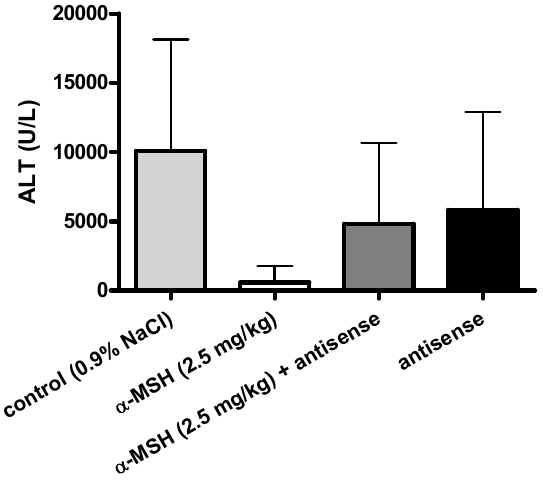
Figure 5. Modulation of α -MSH induced hepatoprotection by means of its antisense penta- peptide LVKAT. Alanine aminotransferase activity (ALT) in plasma of the control and treated animals 24 h after acetaminophen administration.